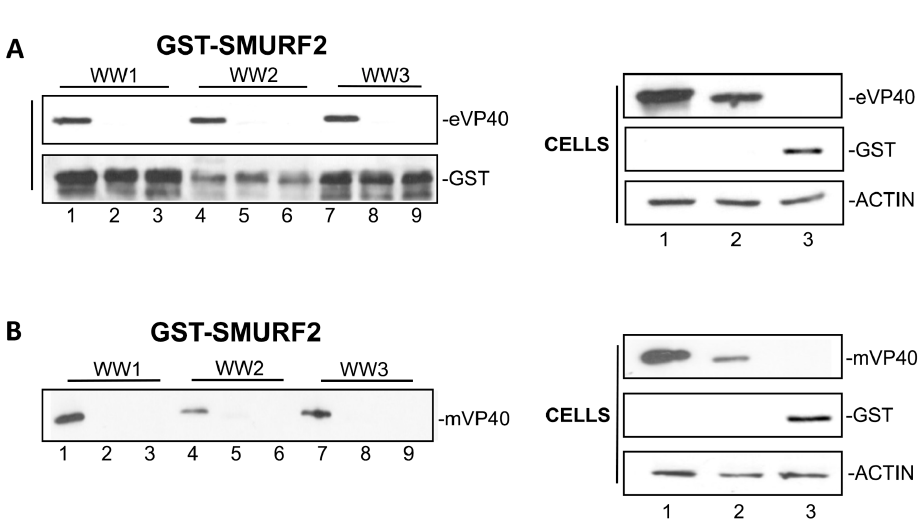
Figure 4. GST pulldown between SMURF2 WW domains and full length VP40. ( A ) GST pulldown assay using purified GST-SMURF2 WW domains 1, 2, and 3 with HEK293T cell extracts containing eVP40 WT (lanes 1, 4, and 7), eVP40 PPxY mutant (lanes 2, 5, and 8), or GST alone (lanes 3, 6, and 9). ( B ) GST pulldown assay using purified GST-SMURF2 WW domains 1, 2, and 3 with HEK293T cell extracts containing mVP40 WT (lanes 1, 4, and 7), mVP40 PPxY mutant (lanes 2, 5, and 8), or GST alone (lanes 3, 6, and 9). Input levels of eVP40, mVP40, GST, and actin are shown.